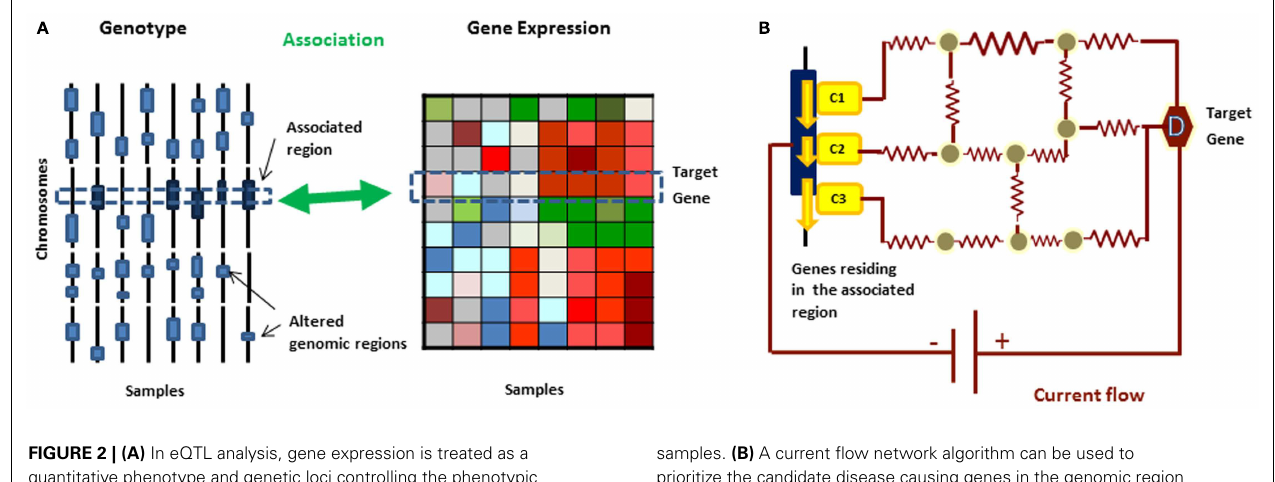
FIGURE 2 | (A) In eQTL analysis, gene expression is treated as a quantitative phenotype and genetic loci controlling the phenotypic changes can be identified based on correlations between the genomic variations and expression profiles from the same set of